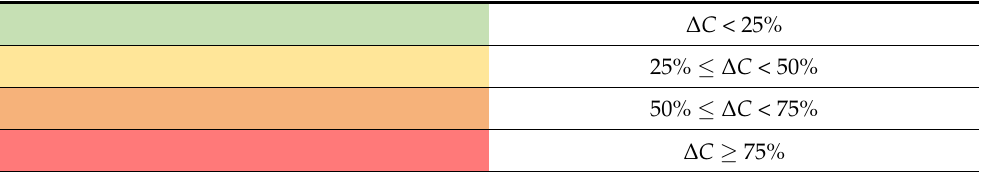
Table 7. Coloristic classification of UBM based on the variations of bedding moduli determined according to different testing procedures.